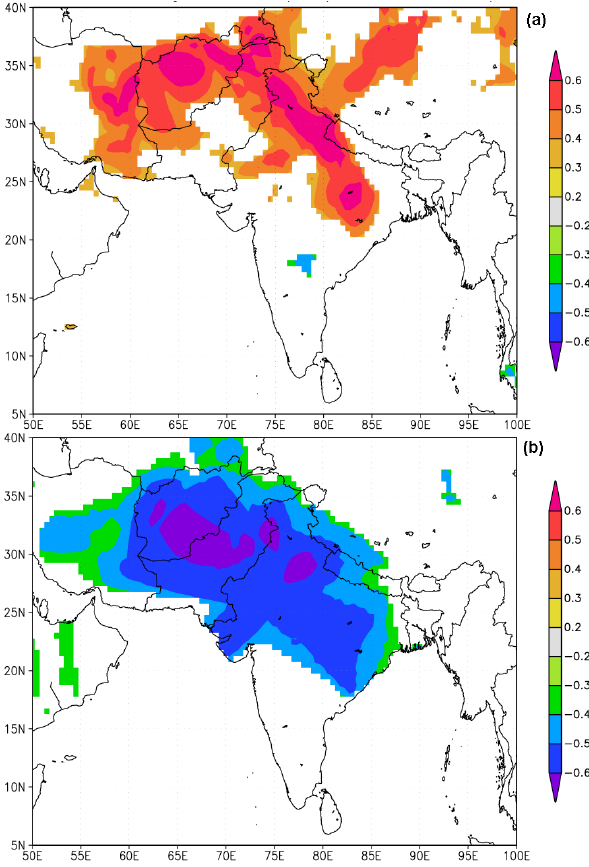
Fig. 2. Pearson’s correlation fields of spring (MAMJ) seasonal total Bhakra inflow with preceding winter (DJF/DJFM) (a) precipitation and (b) daily temperature range over the Western Himalayas and adjoining northern and central Indian plains (also includes part of Pakistan and Afghanistan) for 1978–2004. Shading indicates local statistical significance level at 90%